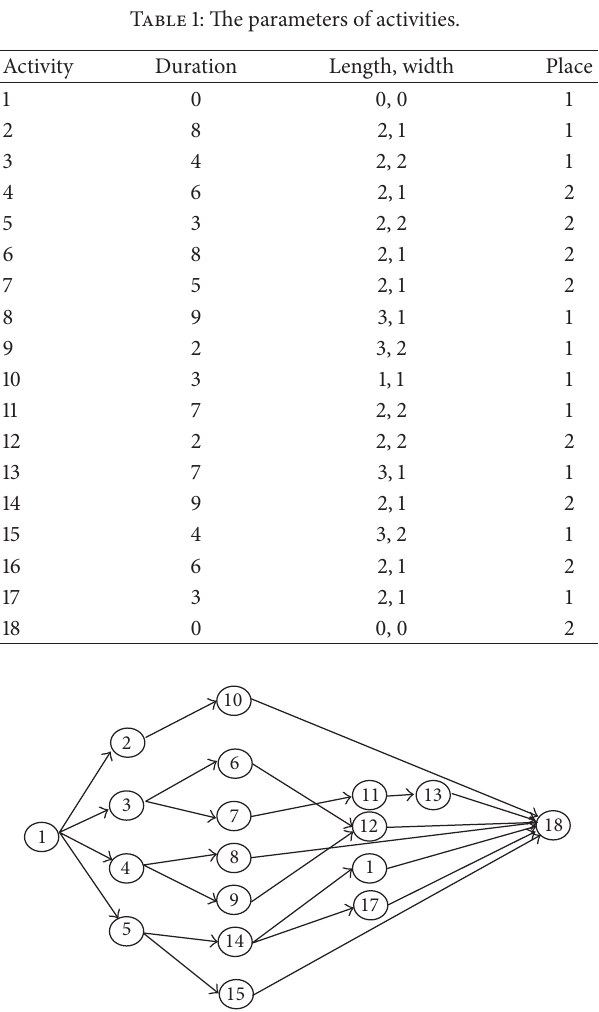
Figure 2: The network diagram of